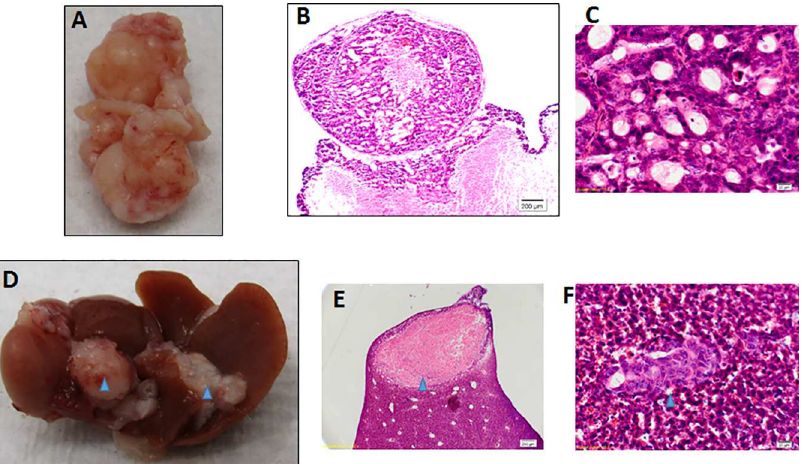
Fig 3. Peritoneal and hepatic tumor xenograft formation after intraperitoneal injection of OE19 cells. (A) Peritonealtumor implantin SCID mice. (B) Low & (C) high power H&E stainedsections of peritoneal tumors. (D) Hepatictumor implants (blue arrows). (E) H&E stainingof hepatictumor implant(blue arrows). (F) H&E staining of OE19 metastasis to liver (blue